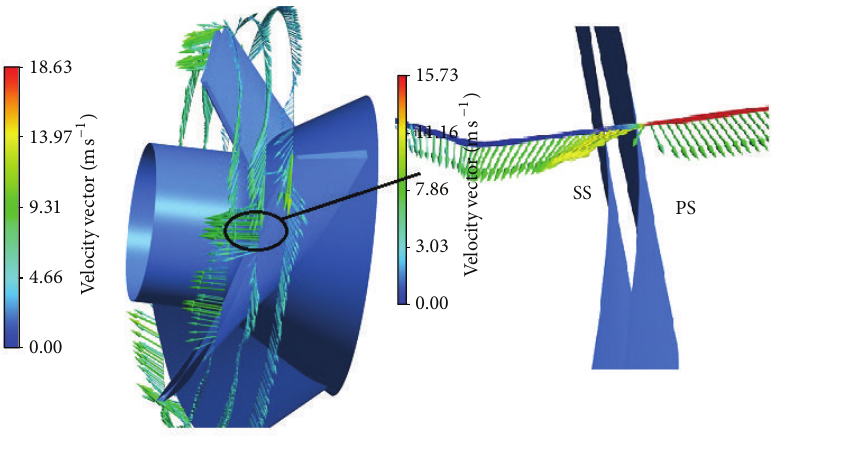
Figure 9: Relative velocity vectors of the leakage flow in the tip clearance at 0.75 𝑄